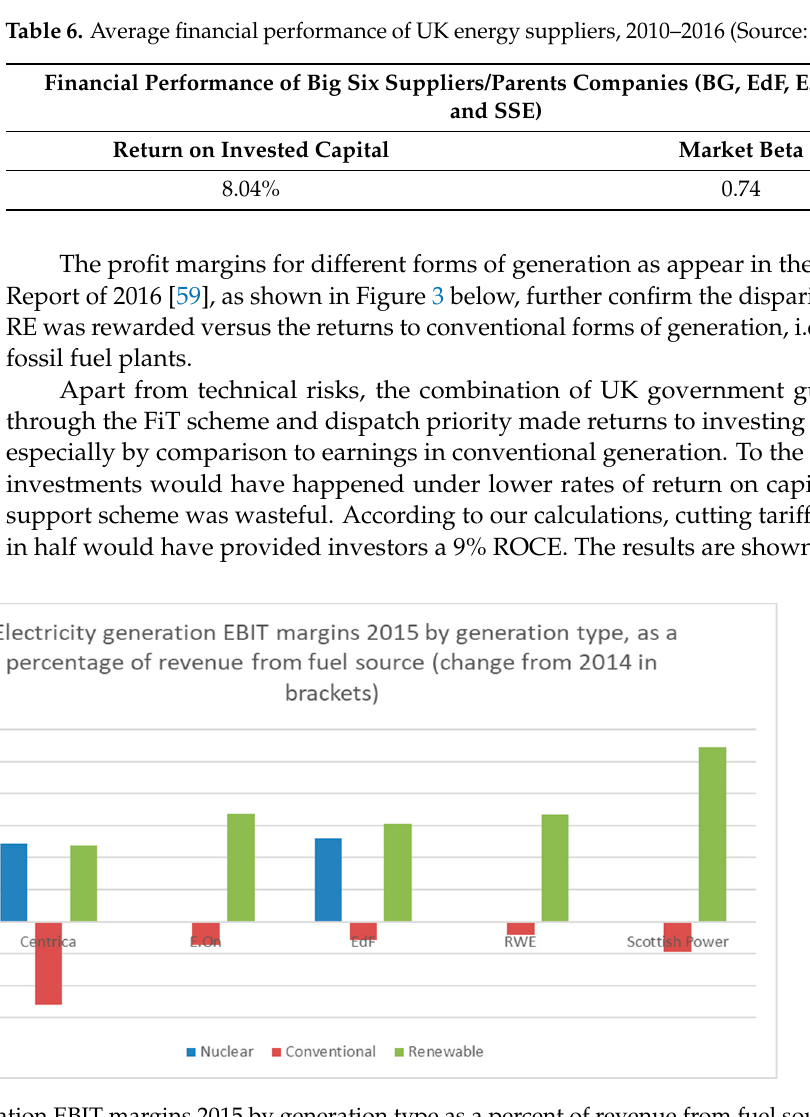
Figure 3. Electricity Generation EBIT margins 2015 by generation type as a percent of revenue from fuel source (change from 2014 in brackets). Source: [59]. Table 7. Model results of implied FiT for 9%